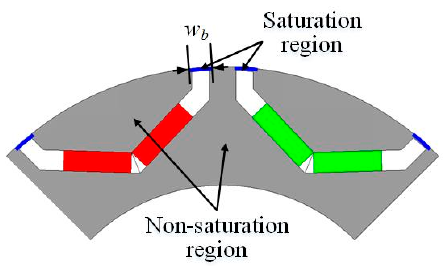
Figure 2. Simplified model of rotor.